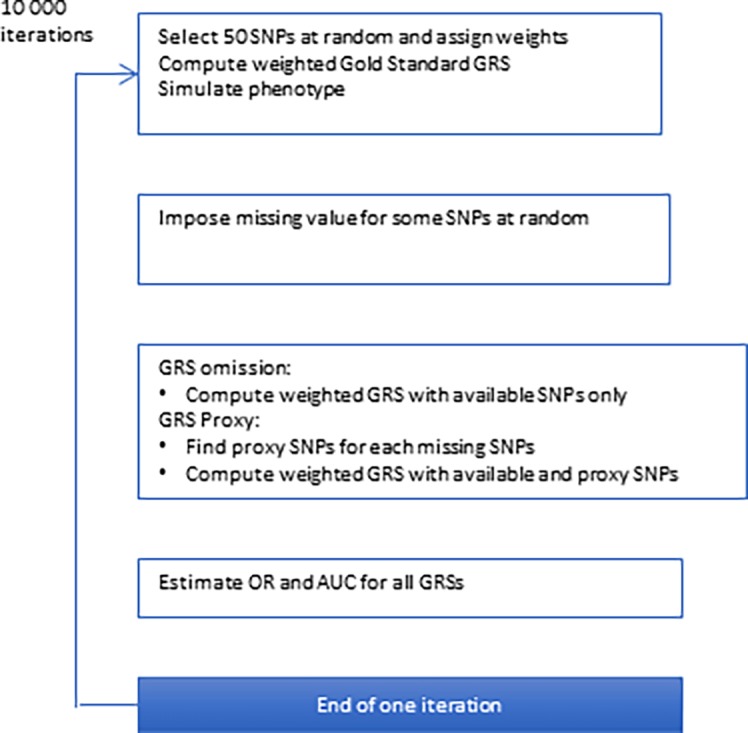
Schematic overview of the algorithm used for simulation of weighted GRS.